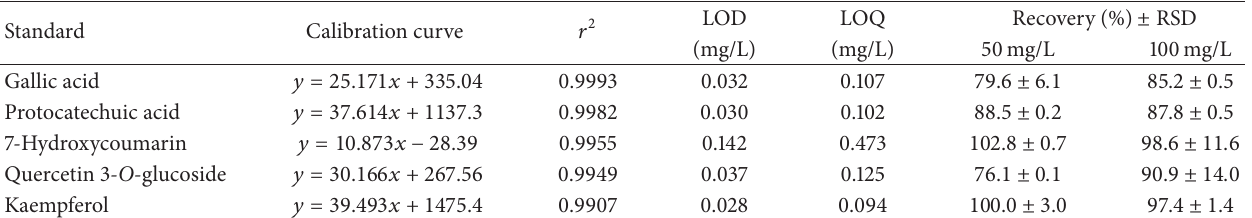
Table 2: Regression data, limit of detection (LOD), and limit of quantification (LOQ) for the five external standards.